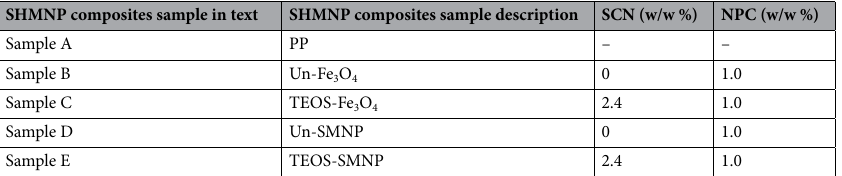
Table 1. Details of the prepared samples. PP pristine polymer (PA6), Un-Fe 3 O 4 uncoated Fe 3 O 4 , TEOS-